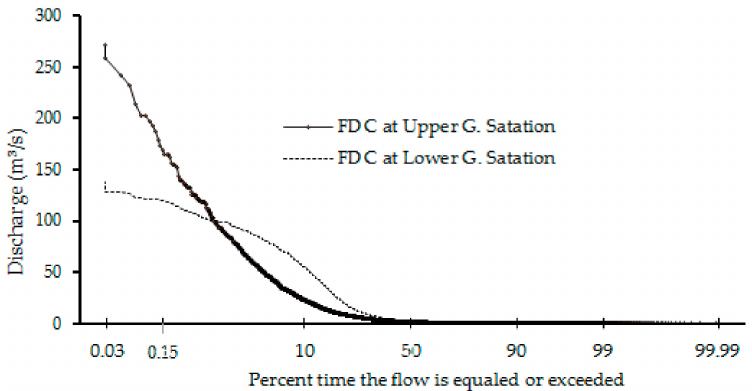
Figure 11. Flow duration curves at the Lower and Upper gauging stations (data source: Ministry of Water, Irrigation and Energy).